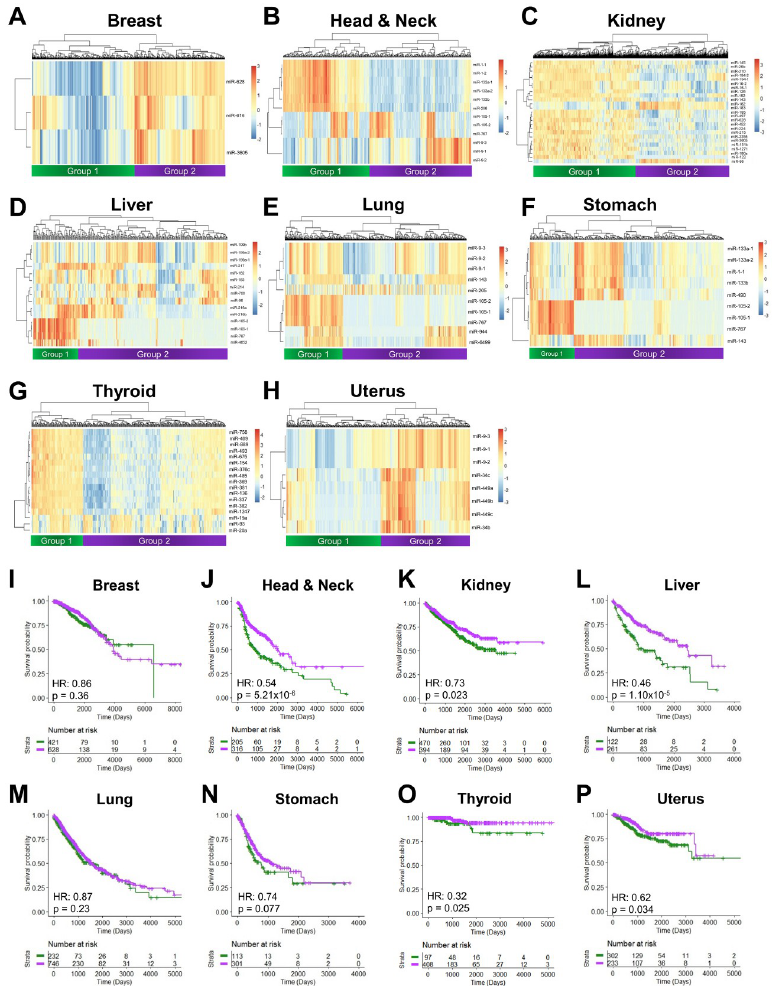
Fig 4. Patient stratification and survival analysis using bimodal miRNA modules. (A-H) Hierarchical clustering was performed using bimodal miRNA co-expression modules, and patients were divided into two groups. (I-P) Using the two groups, a Cox proportional hazards regression was fit for each cancer type. The reported hazard ratio (HR) denotes the risk of death in Group 2 (purple) compared to Group 1 (green). The statistical significance (p-value) of each HR was determined using a Wald